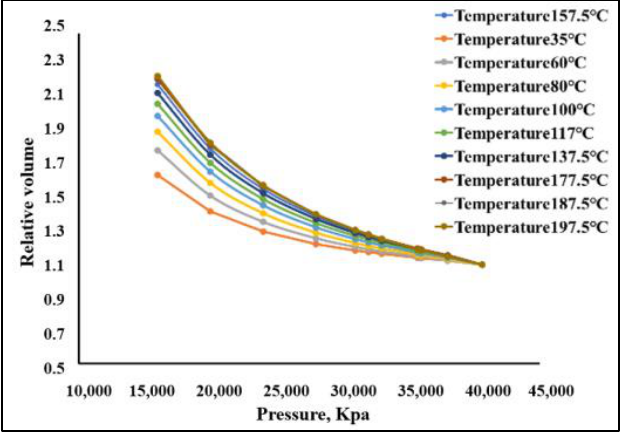
Figure 6. PV relationship at different temperatures.